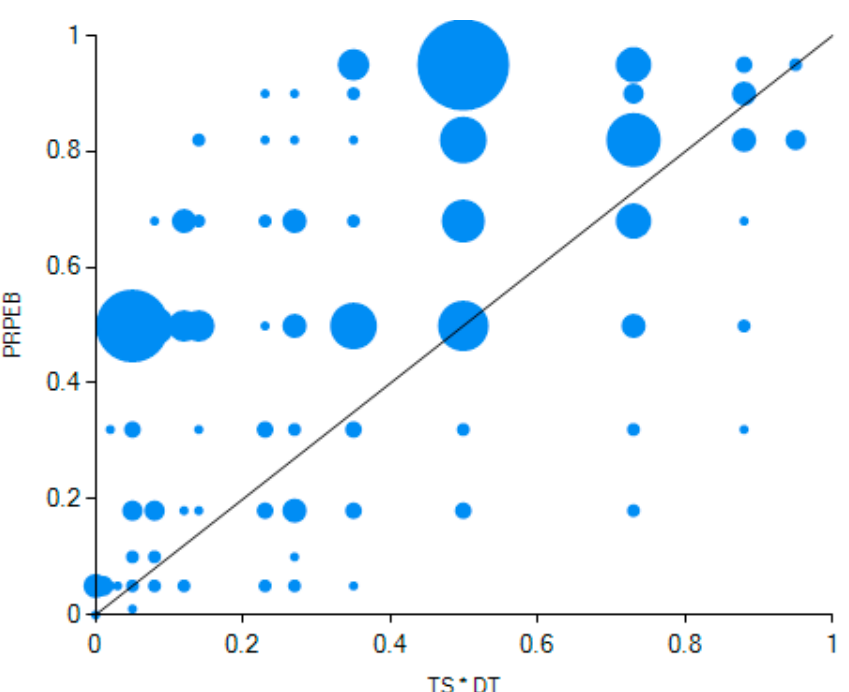
Figure 2. Explanation example of configuration 1 in the private pro-environmental behavior mode.